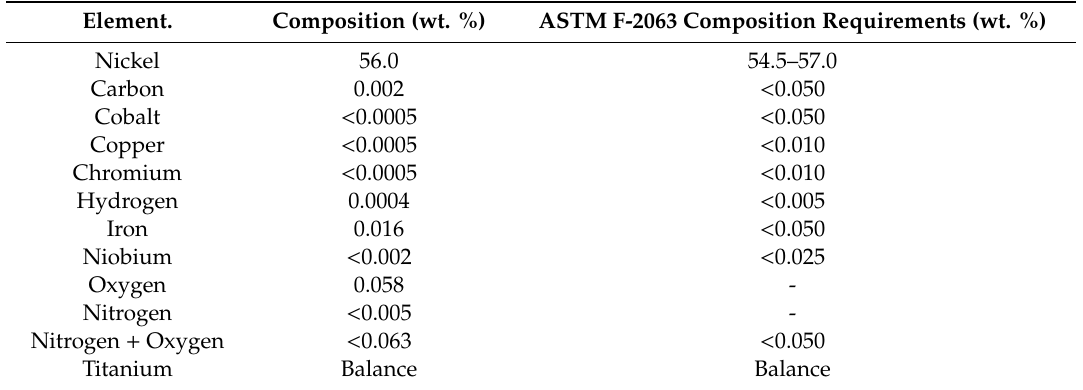
Table 6. The results of the chemical composition